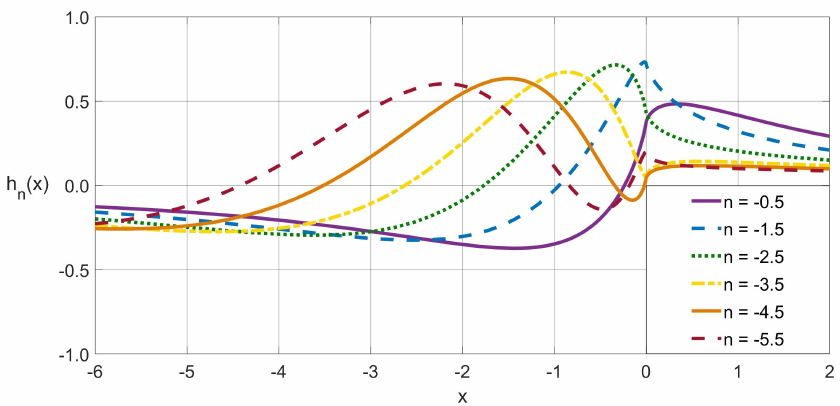
Figure 8. Havelock functions with negative n + 1/2 orders as a function of argument x